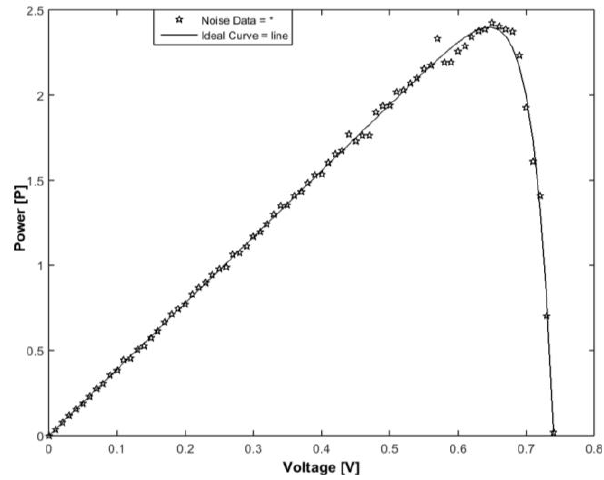
Figure 8 . P-V curve of noise data.